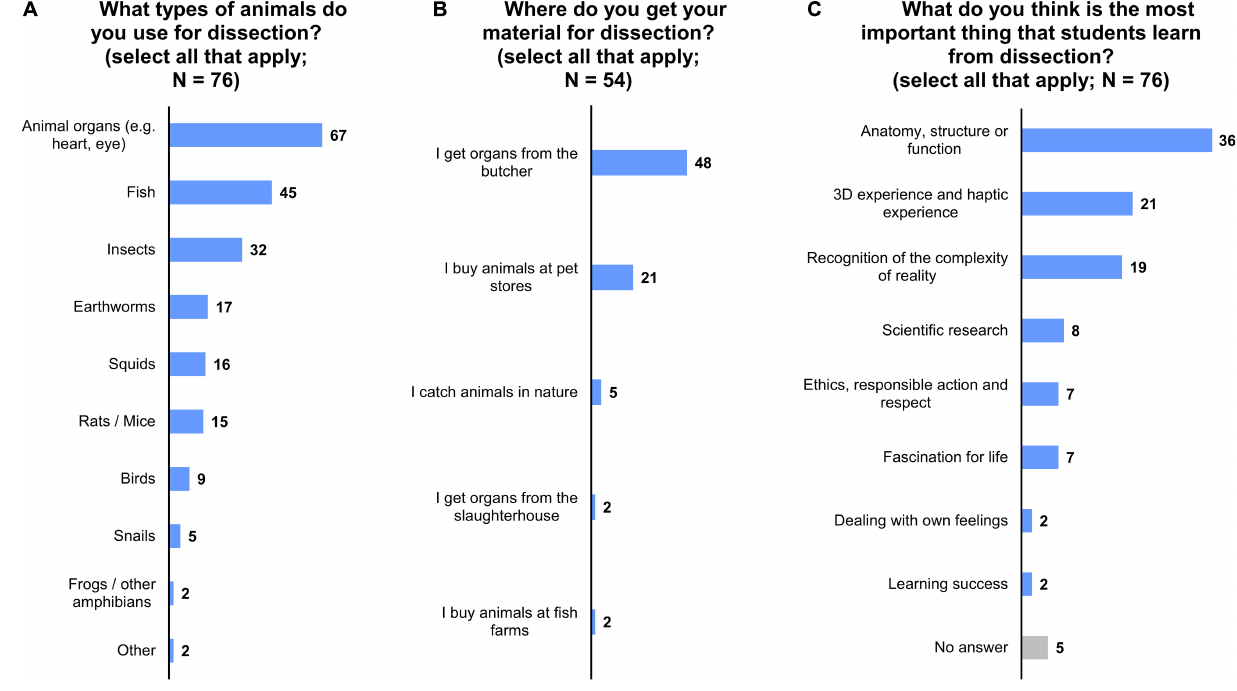
Frontiers in Education |